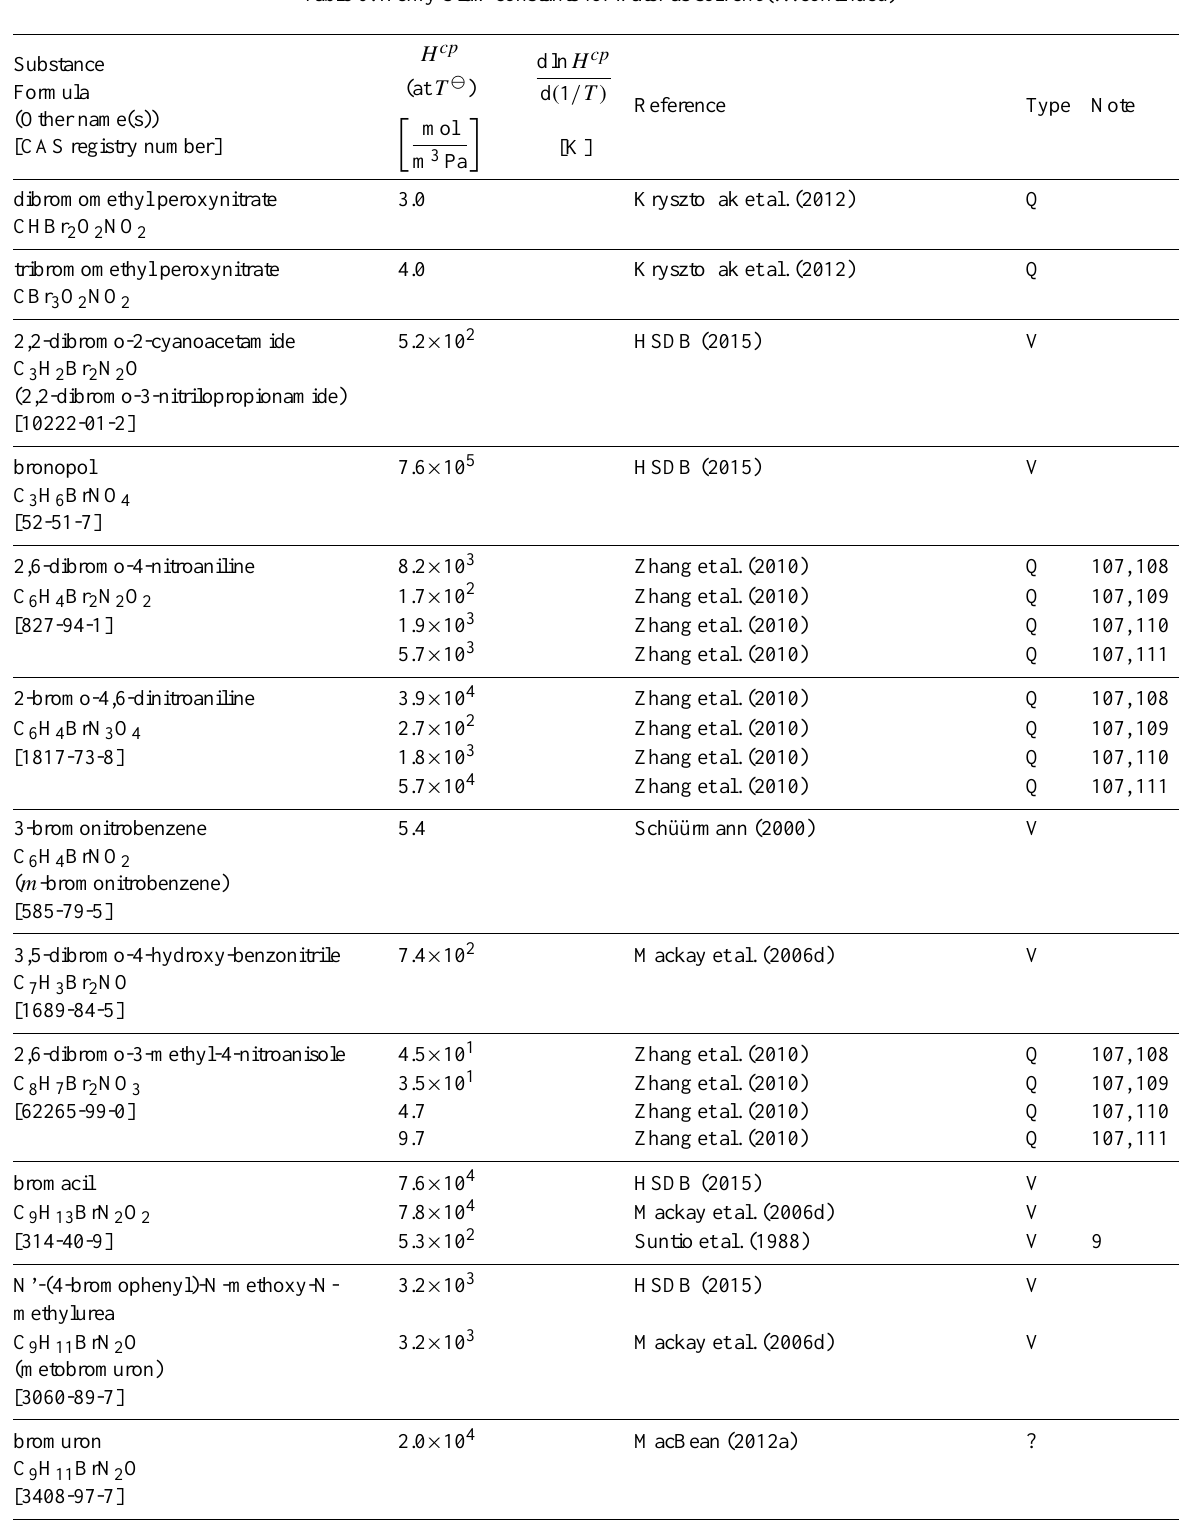
Table 6: Henry’s law constants for water as solvent